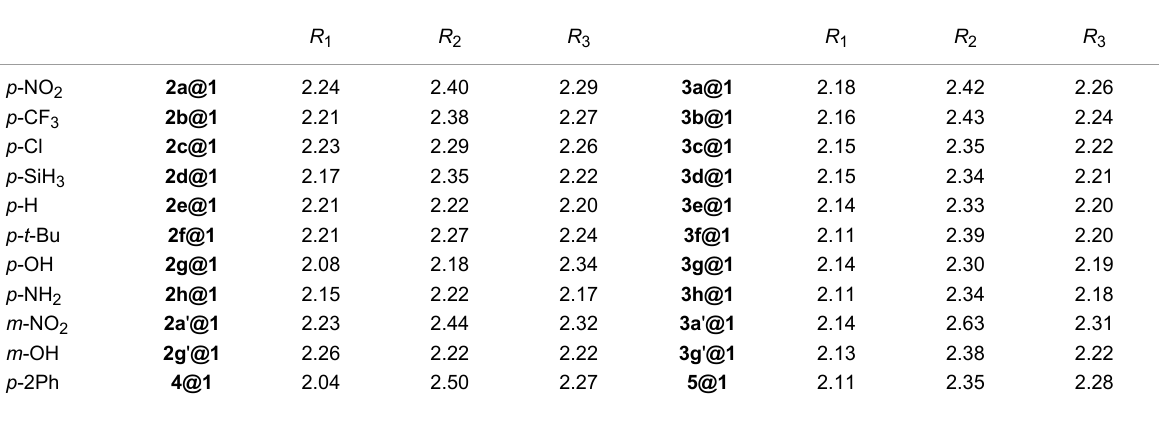
Table 3: Hydrogen bond distances in Å for the different pseudorotaxane systems, for labeling see Figure 2. The second and third last lines show the substitution at the meta-position.